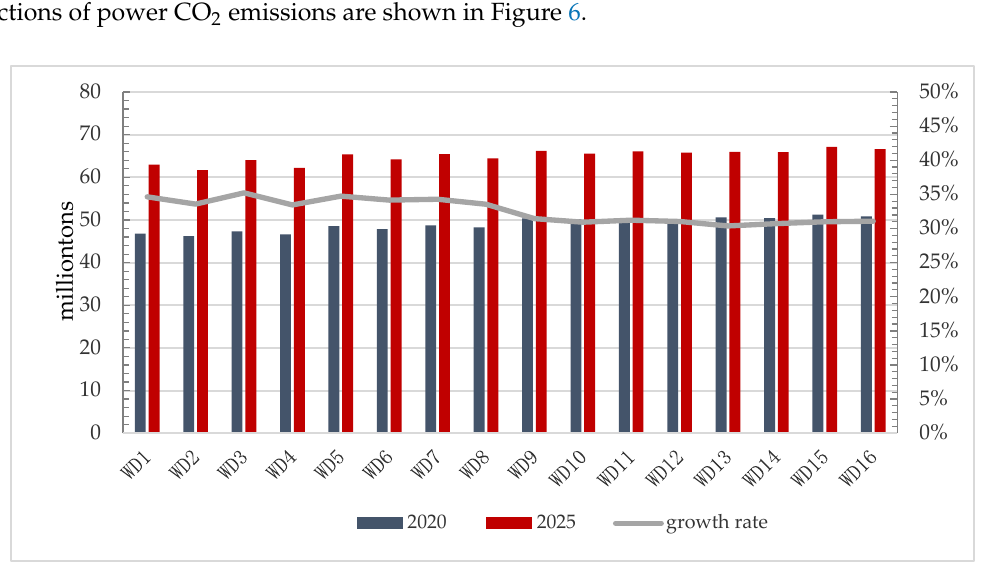
Figure 6. The predictions of power CO 2 emissions for the based development scenario in 2020 and 2025.